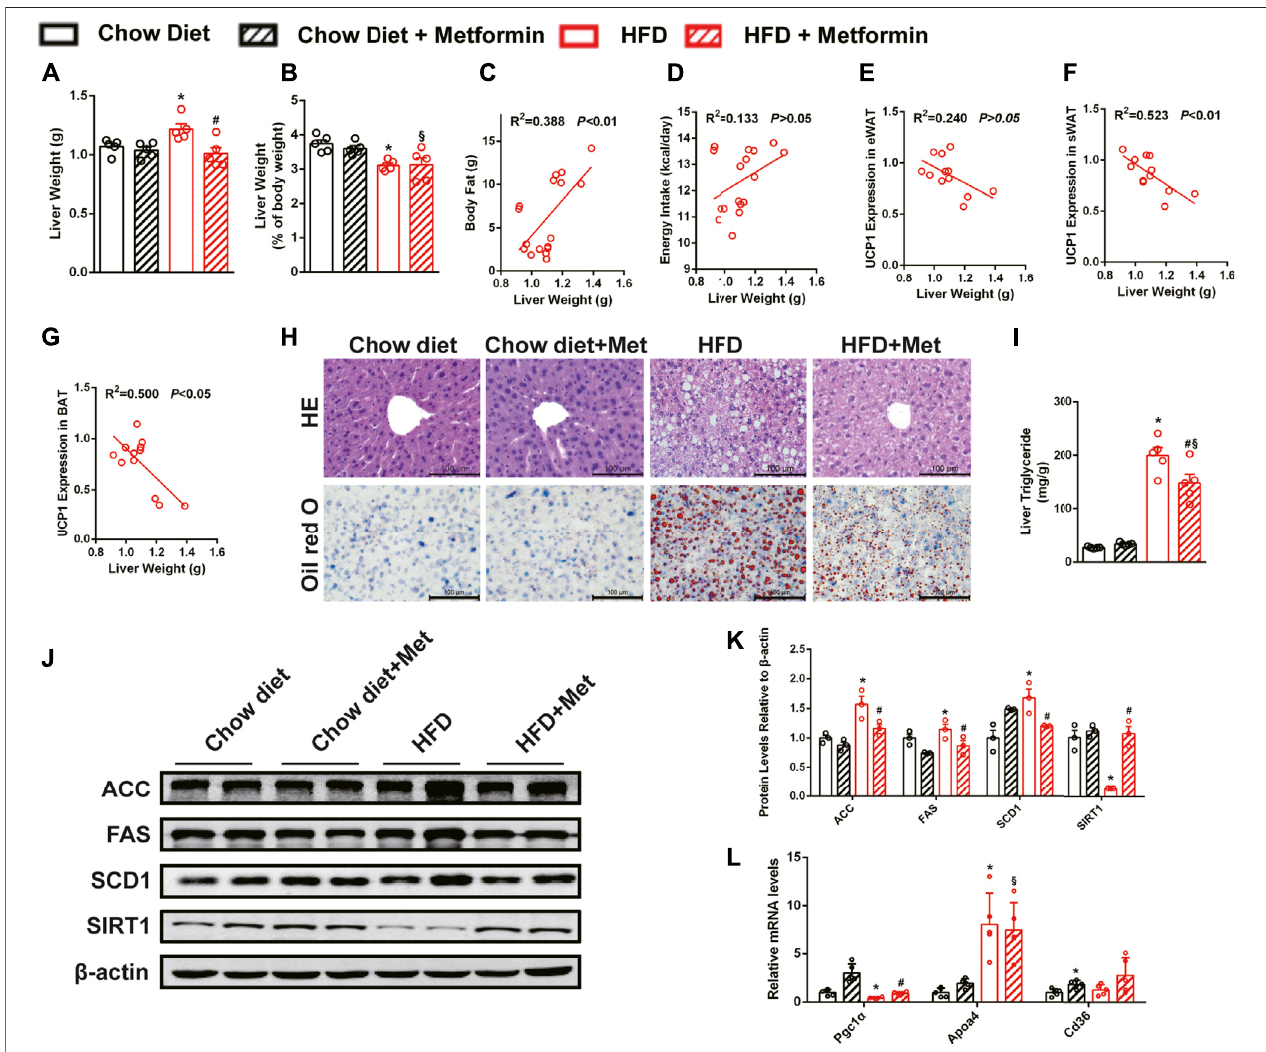
FIGURE3| MetforminalleviateshepaticsteatosisinDIOmice.Metforminreduced (A) liverweightanddidnotchange (B) theliverweighttobodyweightratioinDIOmice. (C) Bodyfat,UCP1expressionsin (F) sWATand (G) BATbutnot (D) energyintakeor (E) UCP1expressionineWATwerecorrelatedwithliverweight. (H) TheH&Estaining,theOilRed Ostainingoftheliverwith × 400magni fi cation,and (I) livertriglyceridecontentindicatedthatmetforminalleviatedhepaticsteatosis( p ＜ 0.05).Metformindownregulated (J,K) the proteinsexpressionsrelatedtolipidmetabolism( p ＜ 0.05)and (L) themRNAexpressionsoflipidmetabolismgenesintheliver( p ＜ 0.05).Dataareshownasmean ± SEM. * p ＜ 0.05, HFD group vs. Chow diet group; # p ＜ 0.05, HFD group vs. HFD + Metformin group; § p ＜ 0.05, HFD + Metformin vs. Chow diet group.